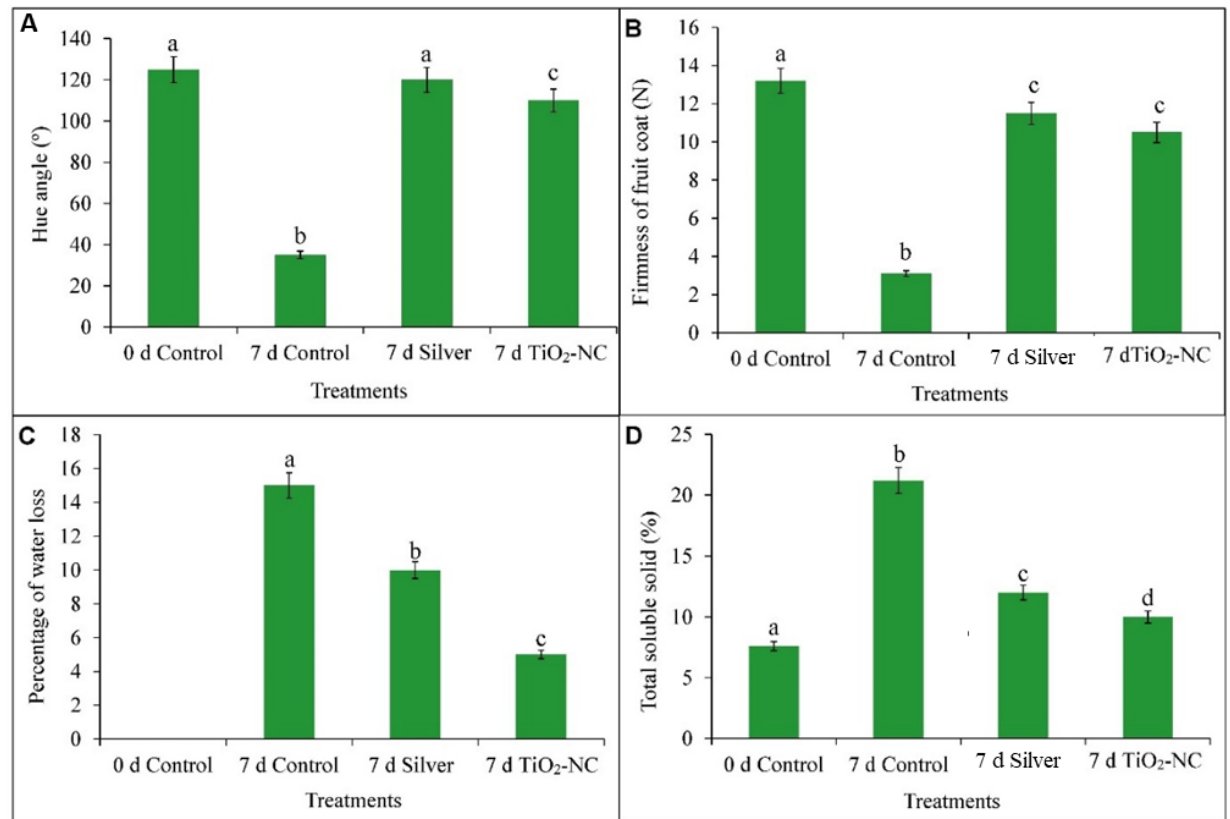
Figure 2. Hue angle ( A ), fruit firmness ( B ), percentage of water loss ( C ) and total soluble solid ( D ) of Capsicum fruit recorded under silver and TiO 2 -NC with respect to control during 0 d and 7 d of postharvest storage at 25 °C. Vertical bars showing SE± 1 ( n = 3) on each column and letters above bars indicate statistical variations between treatments based on One Way ANOVA ( p ≤ 0.05).